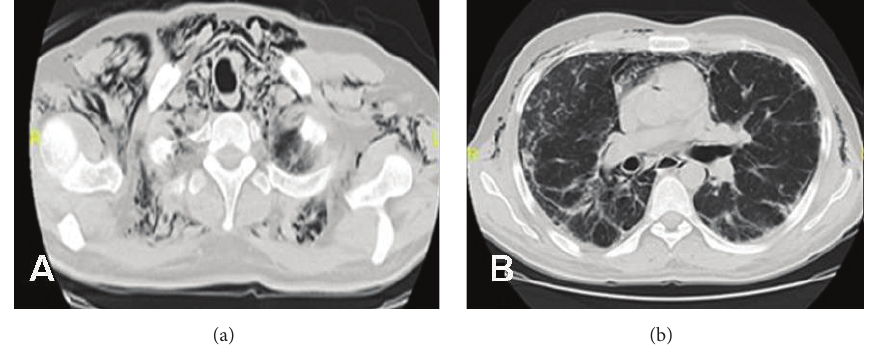
Figure 2: Thorax CT revealing pneumomediastinum, interstitial and subcutaneous emphysema, thickening of interlobular septa, and reticular pattern.